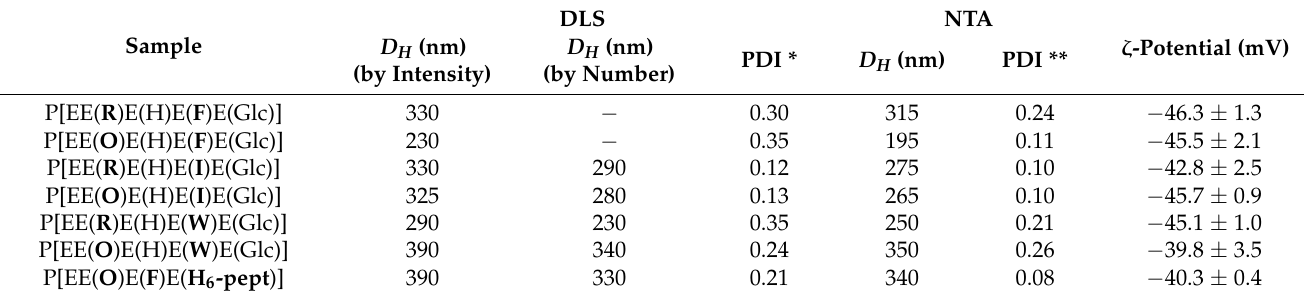
Table 2. Characteristics of nanoparticles obtained from the synthesized amphiphilic polypeptides.